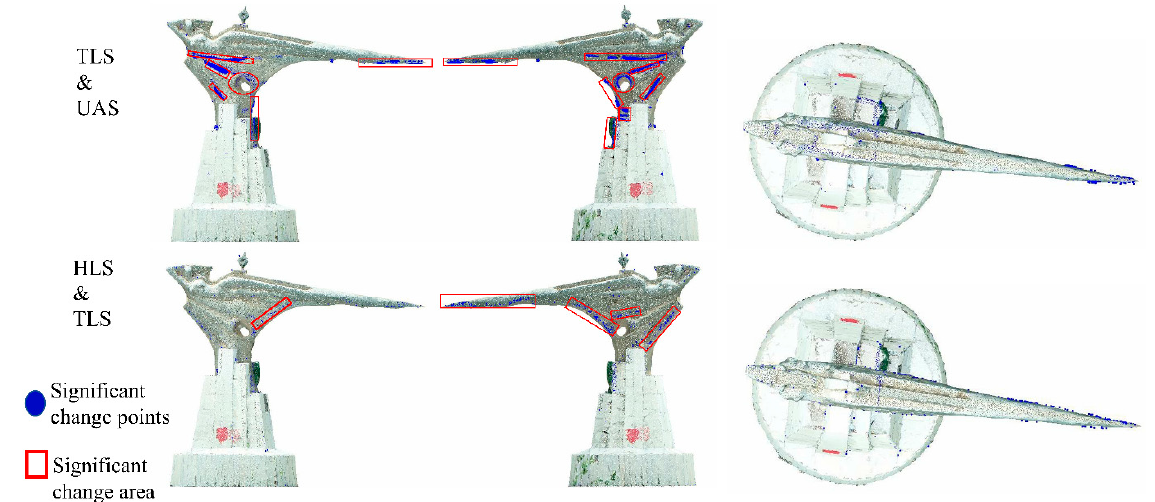
Figure 12. Distribution of significant change points.